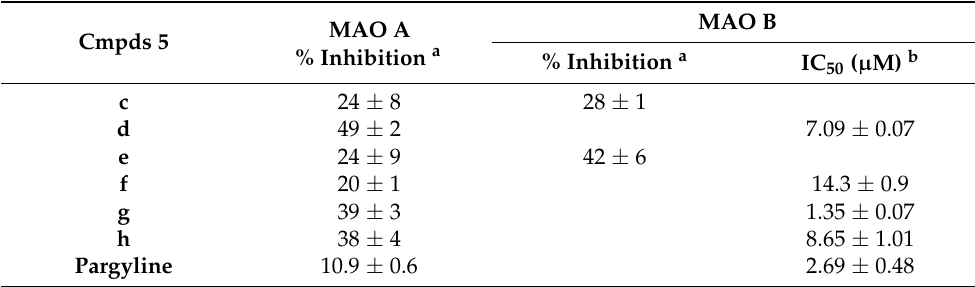
Table 3. Inhibitory activities of compounds 5c – h